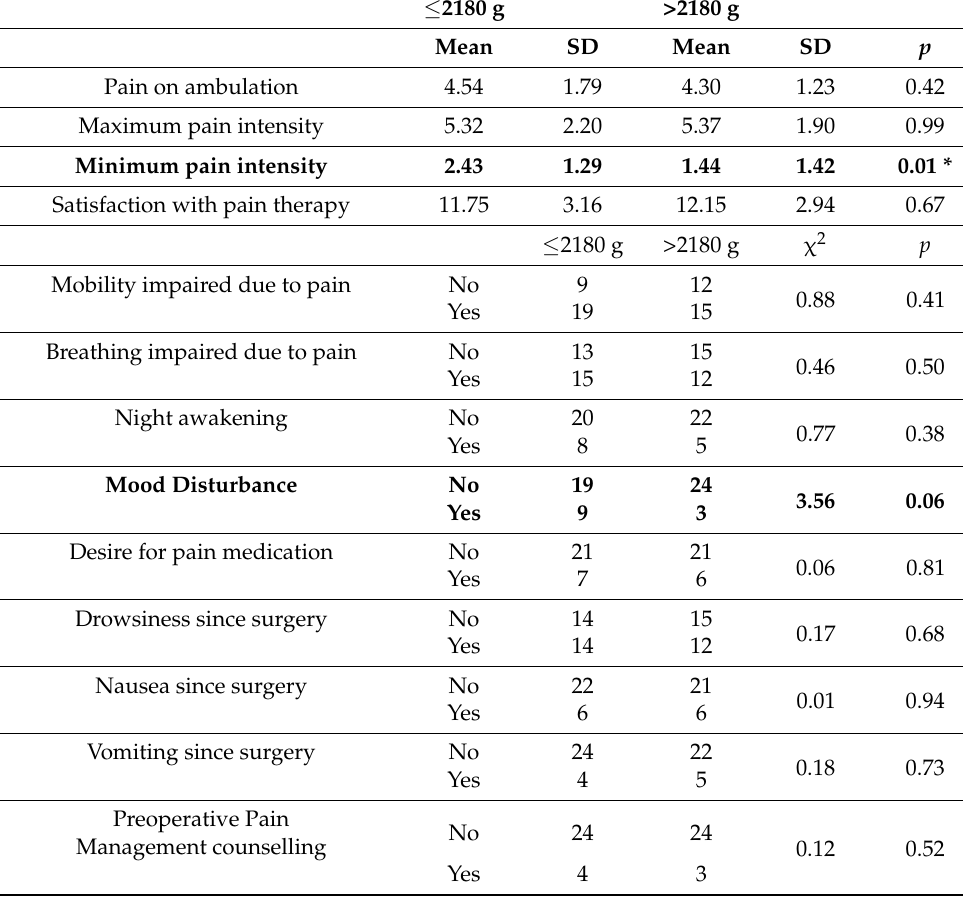
Table 2. Relation between outcome parameters and low-/high resection